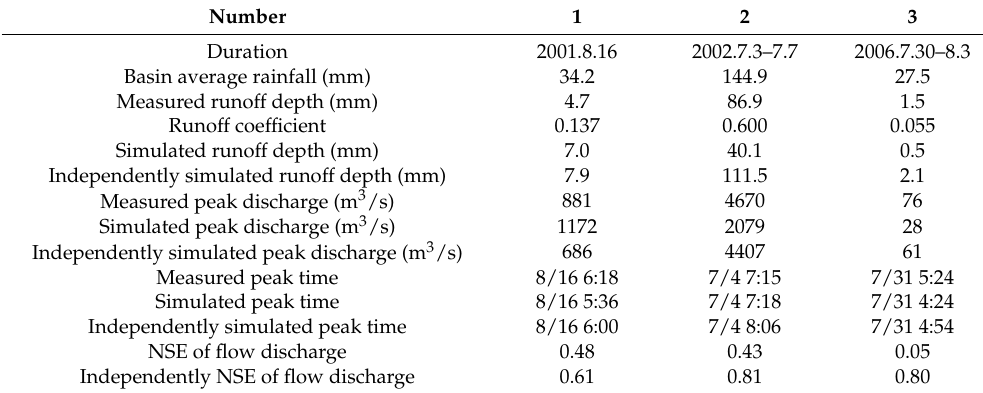
Table 2. Characteristic parameters of the three rainfall events for the upstream of the Qingjian River